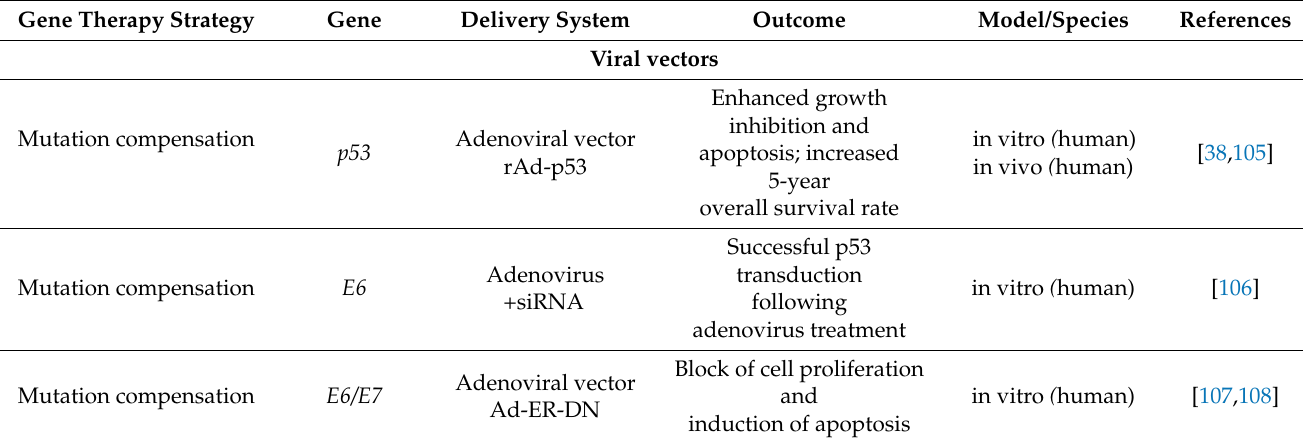
Table 2. Targeted gene therapy approaches for cervical